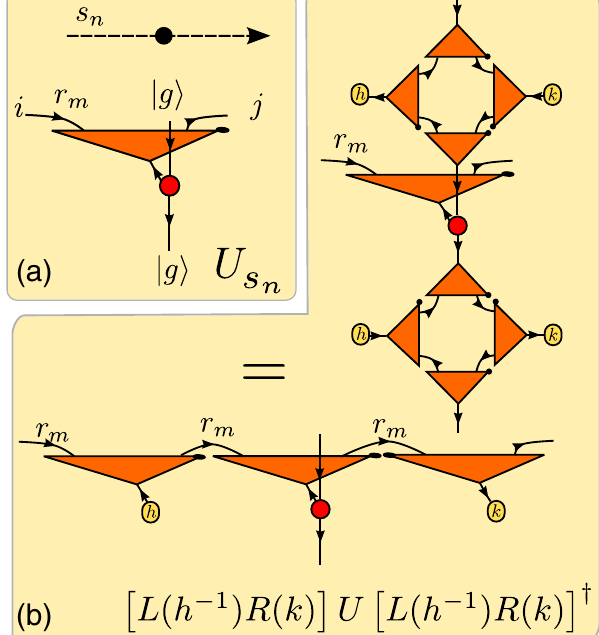
FIG. 8. (a) The U operator of Eq. (19) in the KS LGT. It acts s n on the tensor product of the physical space C ð G Þ of the link s n and of an auxiliary space that defines the irrep r : C ð G Þ ⊗ V . It m r m is built from the contraction of a copy tensor C ≡ j g ih g j ⊗ h g j FIG. 9. The plaquette operator B of Eq. (22) constructed as a p ’ s, acting on the links g Þ i (red circle) and the corresponding rotation matrices Γ matrix-product operator from four U r m ð p n j around a plaquette in the KS LGT. As a consequence of the [defined in Eq. (6)]. (b) The above definition implies that the U covariance of the U transmits the rotation onto the physical index, as induced by under conjugation by L and R [see s n p n conjugation by L and R , to the auxiliary indexes. This property Fig. 8(b)], it transfers the rotation onto the physical legs to allows us to use U rotations onto the auxiliary legs. The operator commutes with the as a building block of the gauge-invariant s n gauge transformations, and, thus, it can be used as a building plaquette operator in Eq. (22), where, thanks to the trace, the block of a gauge-invariant Hamiltonian [see Eq. rotations attached to the auxiliary indexes cancel.